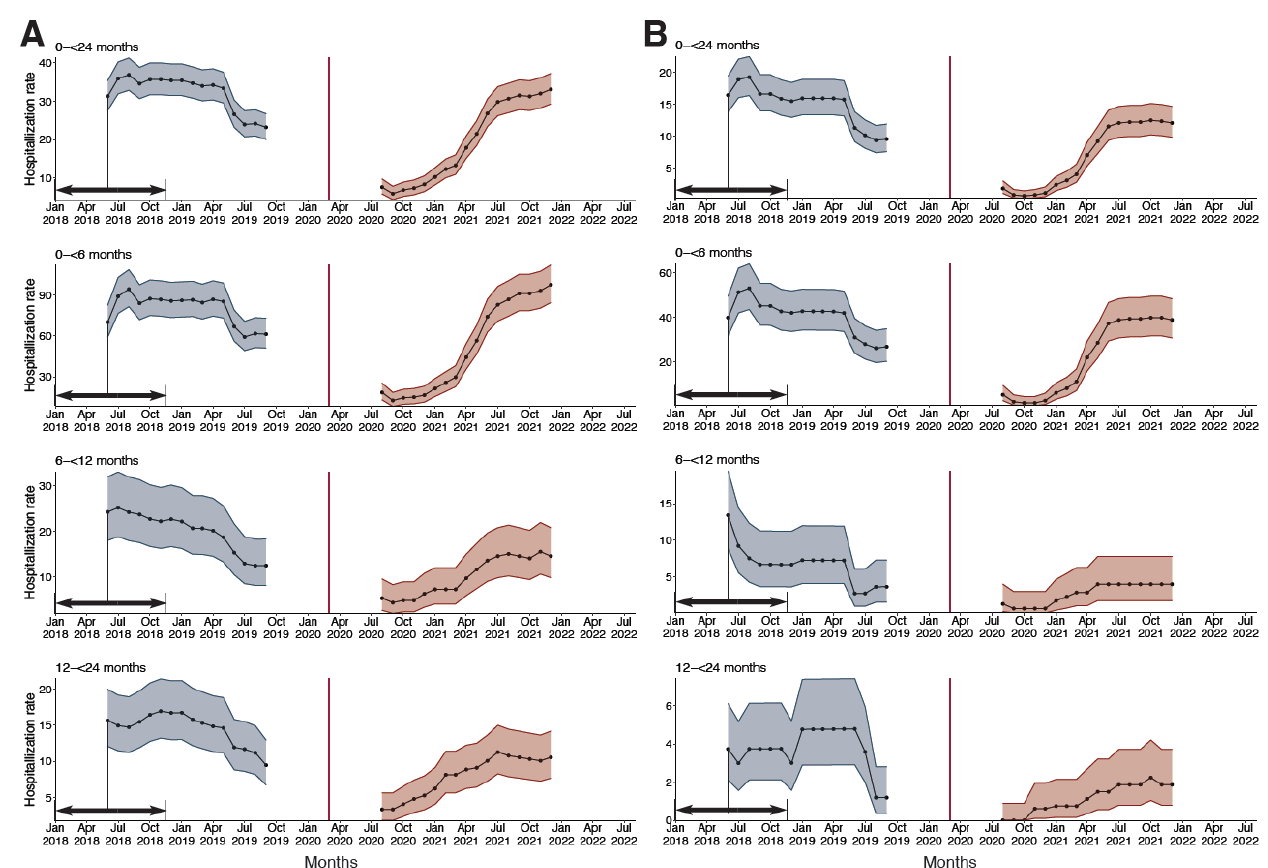
Figure 3. Change in 12-month hospitalization rates (per 1000) of all-cause and RSV-associated ALRI by age group, before and after the onset of the COVID-19 pandemic. ( A ) 12-month all-cause ALRI moving average hospitalization rate. ( B ) 12-month RSV-associated ALRI moving average hospitalization rate. Black arrows denote the time interval used for calculating the 12-month hospitalization rates. Red vertical line: lockdown in Croatia on 16 Mar 2020.